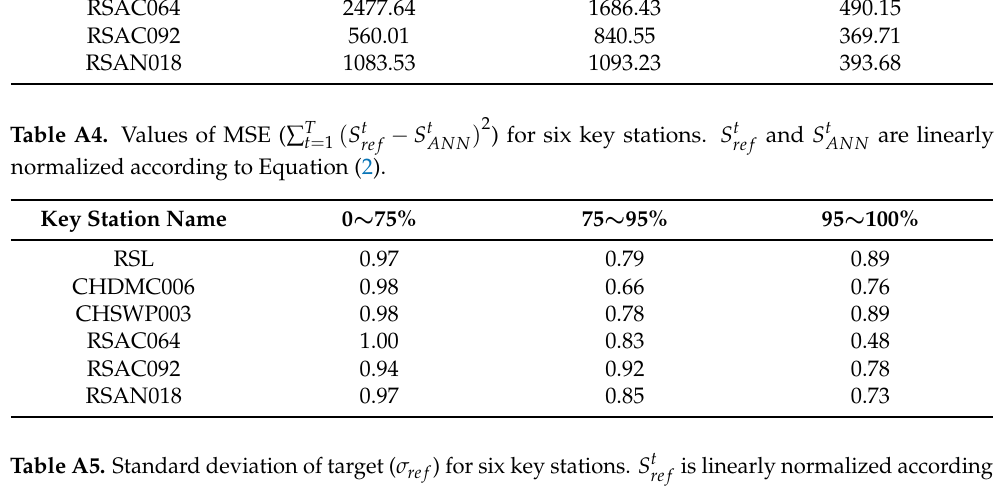
is linearly normalized according ref